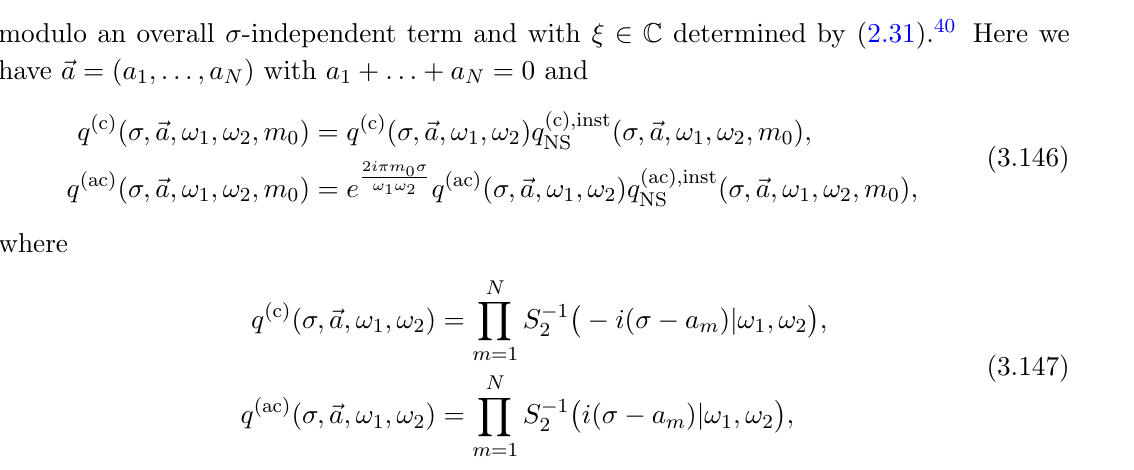
modulo an overall (cid:27) -independent term and with (cid:24) 2 C determined by (2.31). 40 Here